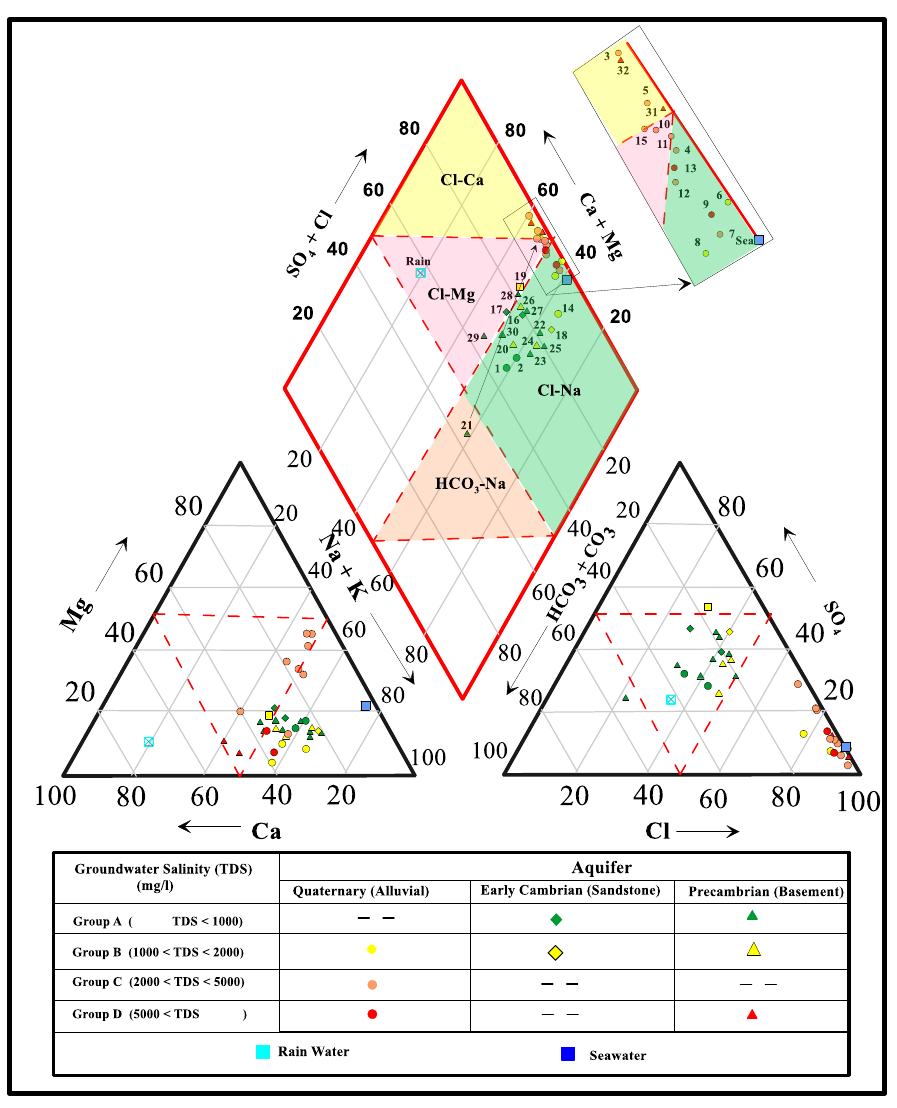
Figure 5. PiperTrilinear diagram of groundwater samples tapped from different aquifers in Dahab watershed.